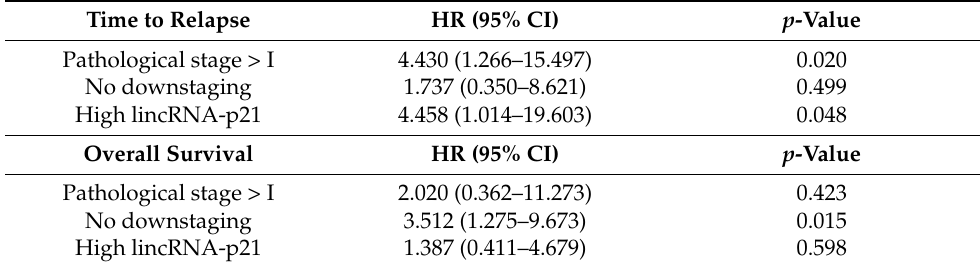
Table 3. Multivariate analysis for TTR and